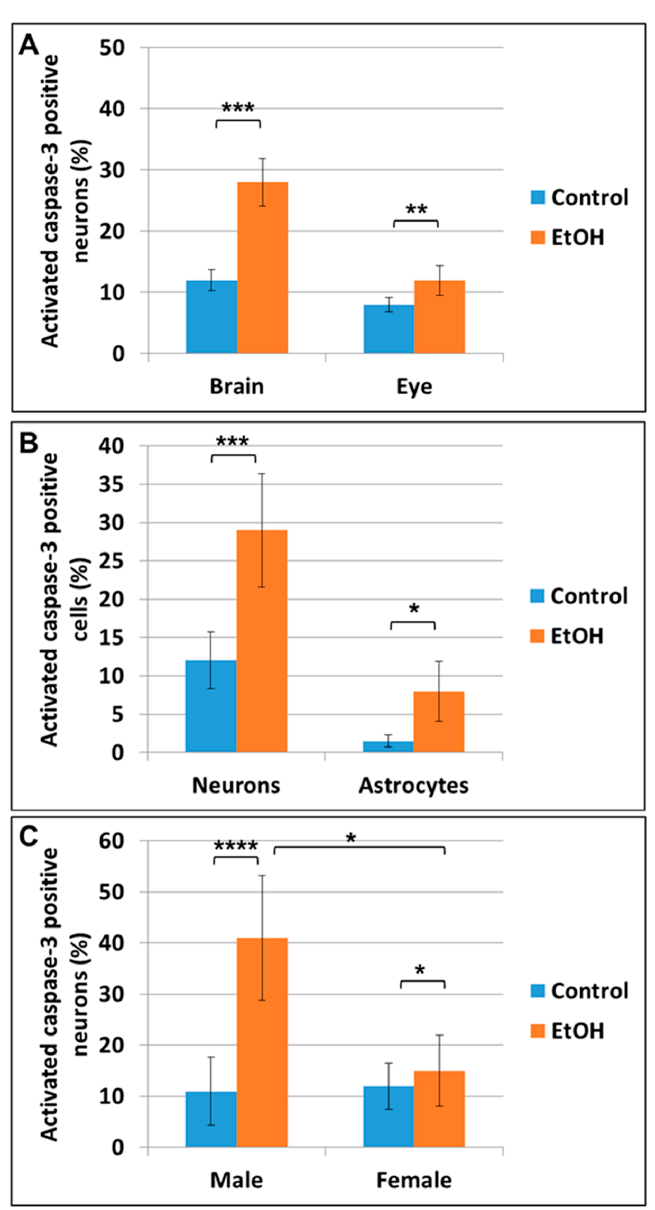
Figure 2. Prenatal EtOH exposure induces neural injury in fetal brain and eye, and affects male fetuses more than females. Human fetal brain and eye tissues from 20 EtOH-exposed fetuses and 20 matched unexposed controls were dissociated through 70 mM mesh, and cells were assayed by FACS using β -Tubulin as a neuronal marker, GFAP as a glial marker, and activated caspase-3 as an apoptotic marker. The value for each fetus was the average of the triplicate determinations. The % of each cell type that was labeled for activated caspase-3 was determined and evaluated with respect to fetal sex and in vivo exposure to EtOH. ( A ) In utero exposure to EtOH increased apoptotic signaling in neurons of fetal brains and eyes. β -Tubulin was used as a neuronal marker. ( B ) Apoptotic signaling was increased in astrocytes and neurons in EtOH-exposed brains ( n = 20 fetuses). ( C ) The effect of exposure to EtOH on neuronal apoptotic signaling was greater in male fetuses (3.65-fold) than in females (1.50-fold). Each assay was performed in triplicate. Error bars indicate standard deviations based on numbers of fetuses, not the number of triplicated assays. * p < 0.05; ** p < 0.01; *** p < 0.001; **** p < 0.0001. In ( C ), the p value * above the top line linking the male and female groups refers to the difference between male and female fetuses regarding the fold changes in apoptotic signaling in EtOH-exposed vs. non-exposed control